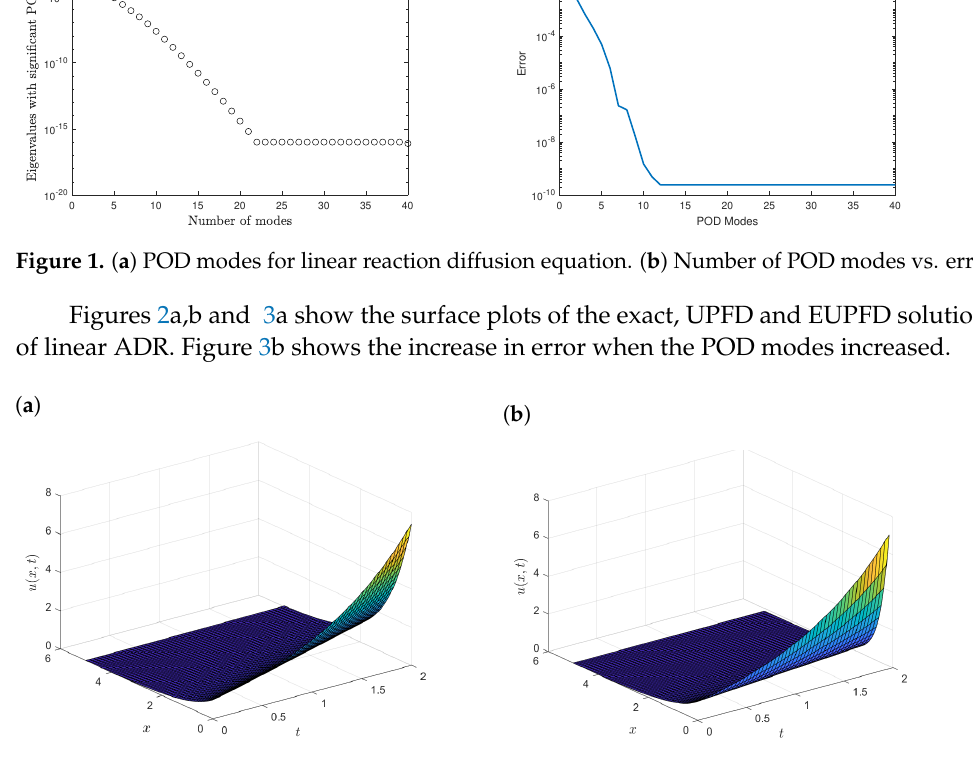
Figure 2. ( a ) Surface plot of the exact solution of the linear ADR equation. ( b ) Surface plot of the UPFD solution of the linear ADR equation.